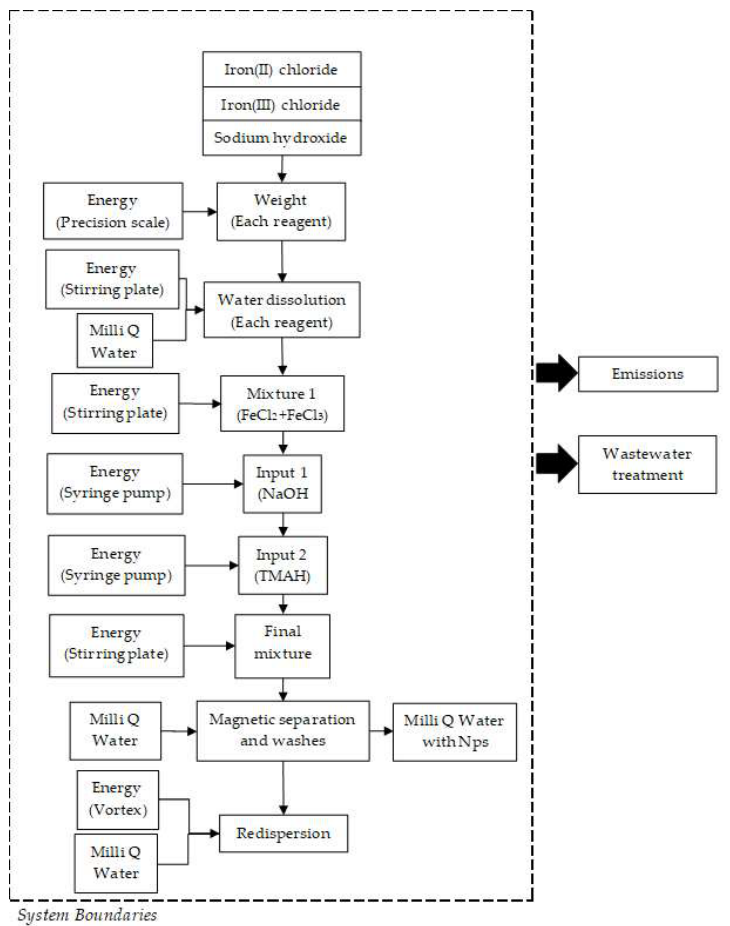
Figure 3. Flowchart diagram of the co−precipitation method for the synthesis of Fe 3 O 4 NPs. The system boundaries are defined by the dotted framework.